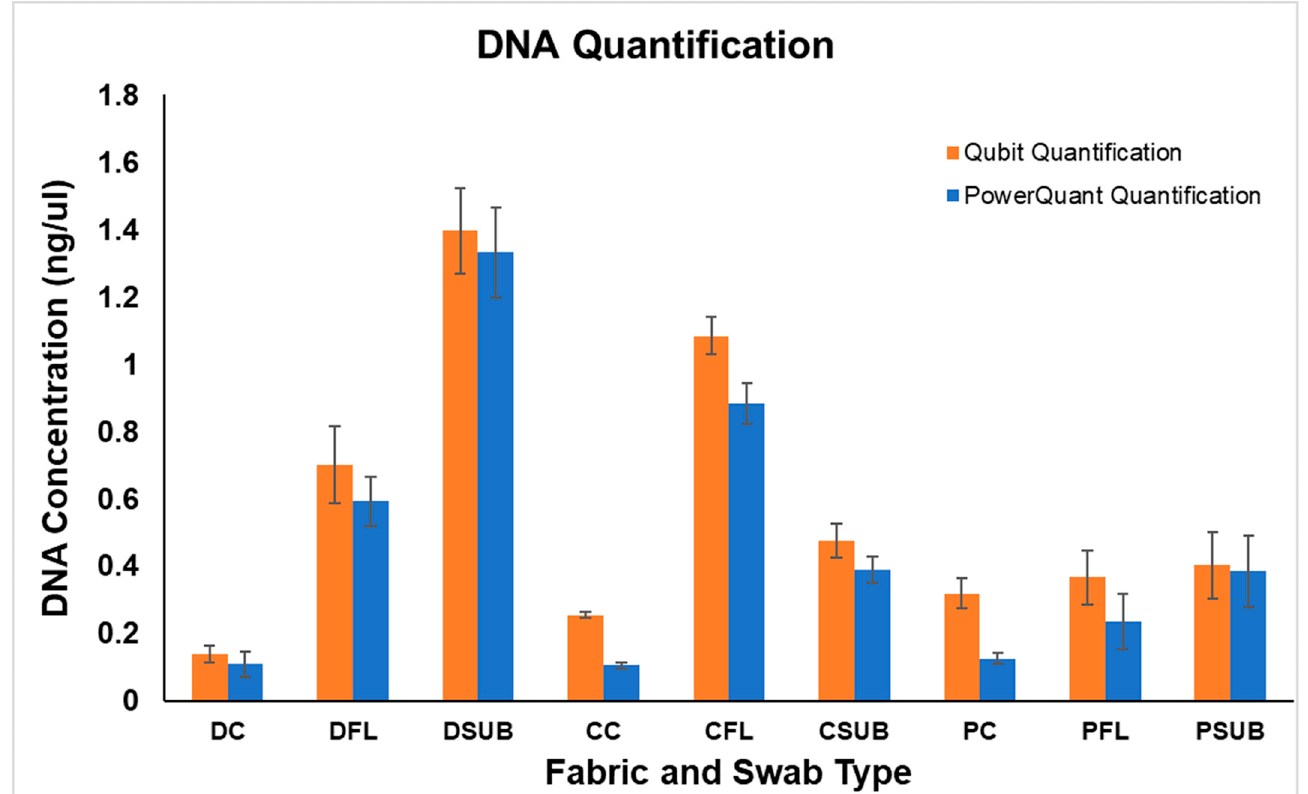
Figure 3. Graphical comparison between Qubit Quantification vs. PowerQuant Quantification, including standard error bars. DC, Denim Cotton Swab; DFL, Denim Flock Swab; DSUB, Denim Subungal Swab; CC, Cotton Cotton Swab; CFL, Cotton Flock Swab; CSUB, Cotton Subungal Swab; PC, Polyester Cotton Swab; PFL, Polyester Flock Swab; PSUB, Polyester Subungal Swab.